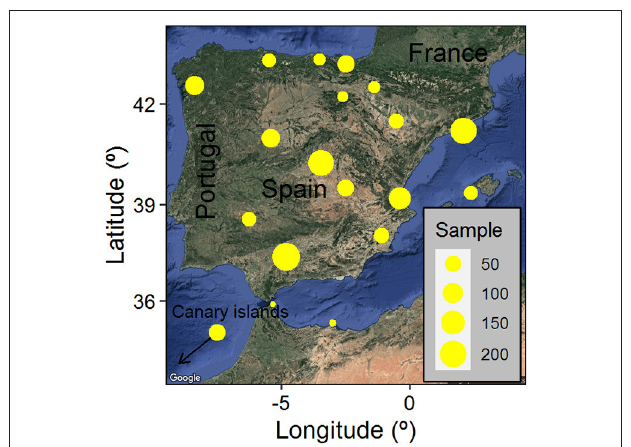
FIGURE 1 | Spatial distribution and sample size of the telephone survey using computer assisted telephone interviewing, carried out in 2017 at the national level in Spain. Sampling was randomly performed, and we applied a weighting factor to maintain the sample size per Spanish regions proportional to the adult population of each region (in yellow, n = 19 regions). This map has been developed using the R-package “ggmap” (Kahle and Wickham,